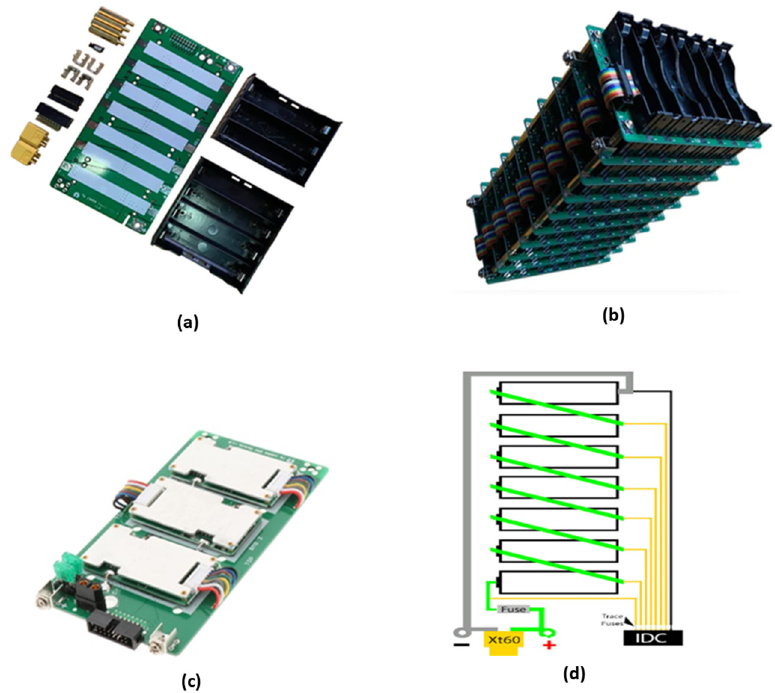
Figure 12. Open-source, Do-it-yourself modular battery storage kit: ( a ) exploded view; ( b ) assembled and stacked; ( c ) battery management module; ( d ) simplified circuit representation of the battery module [128].